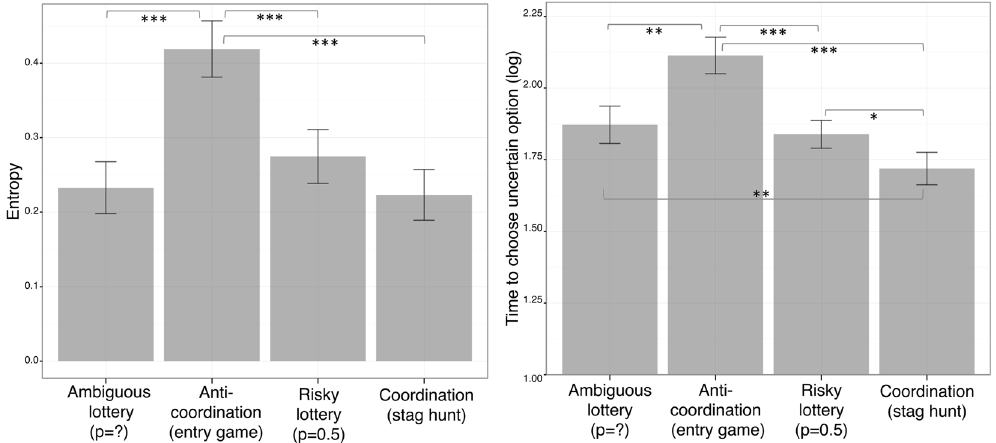
Figure 4. Left: entropy is increased in games involving anti-coordination (i.e., an entry game); relative to any of the other tested environments. Right: coordination and anti-coordination oppositely affect decision times, respectively facilitating and “disfacilitating” uncertain choices, relative to risky and ambiguous lotteries with the same potential monetary payoffs. Error bars represent standard error of the means. Asterisks represent significance levels of Wilcoxon signed-rank tests. *** p < 0.001, ** p < 0.01, * p <